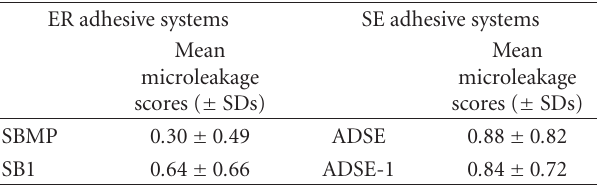
Figure 1: Diagram showing placement of the three grooves on each restoration to provide eight observation areas.